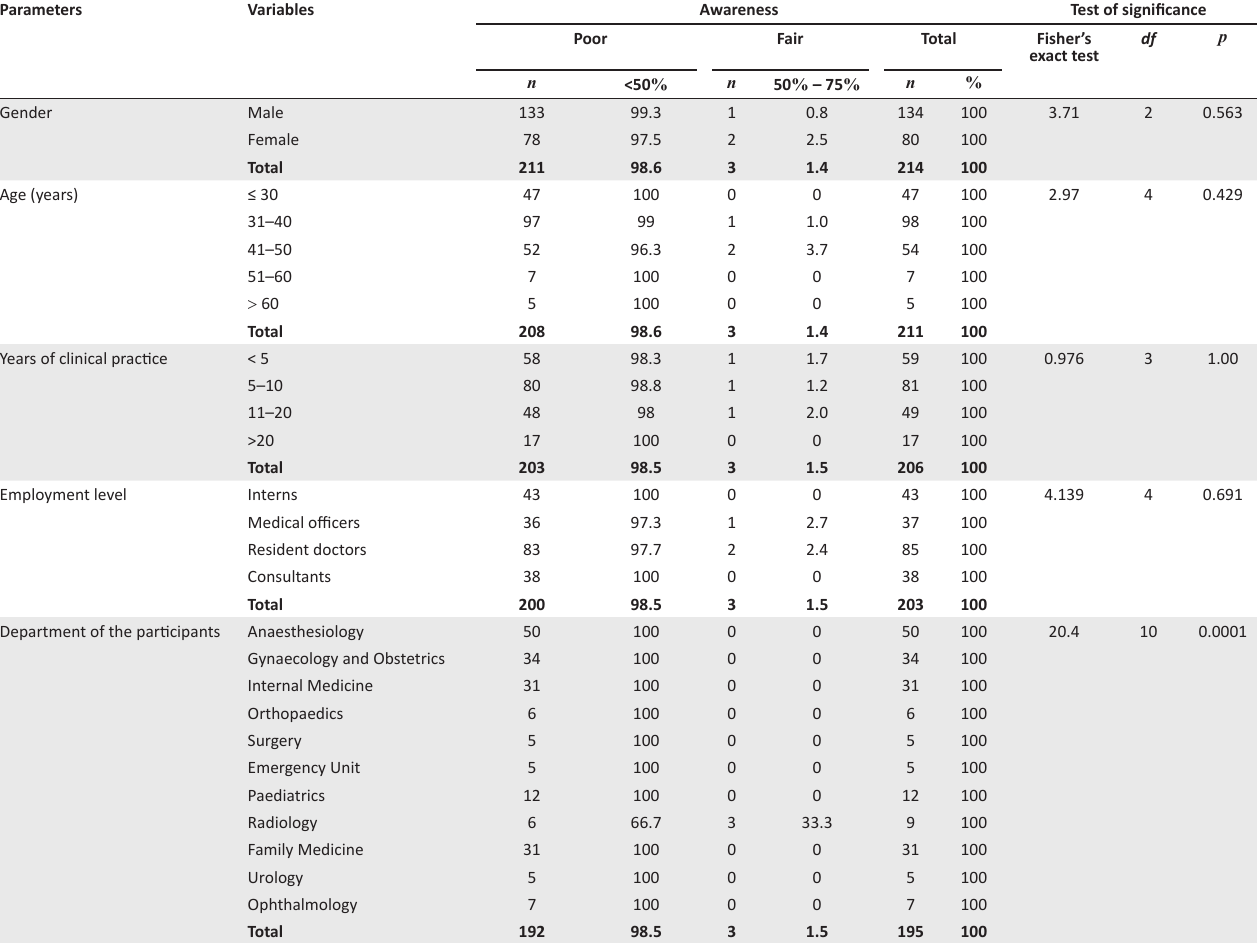
TABLE 5: Association between respondents’ socio-demographic characteristics and their awareness of exposure to diagnostic radiation. Parameters